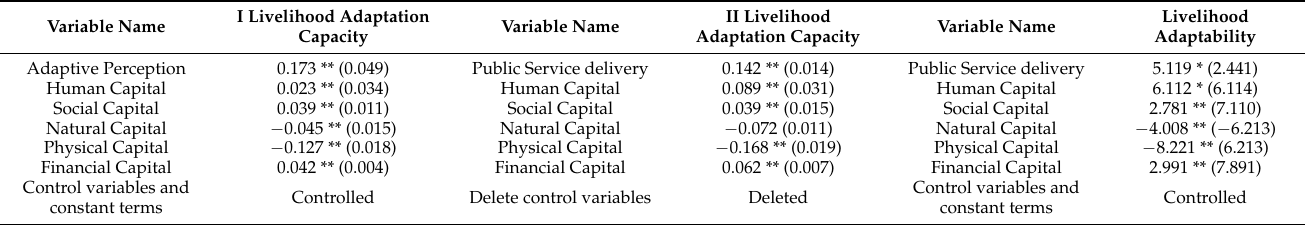
Table 9. Robustness test